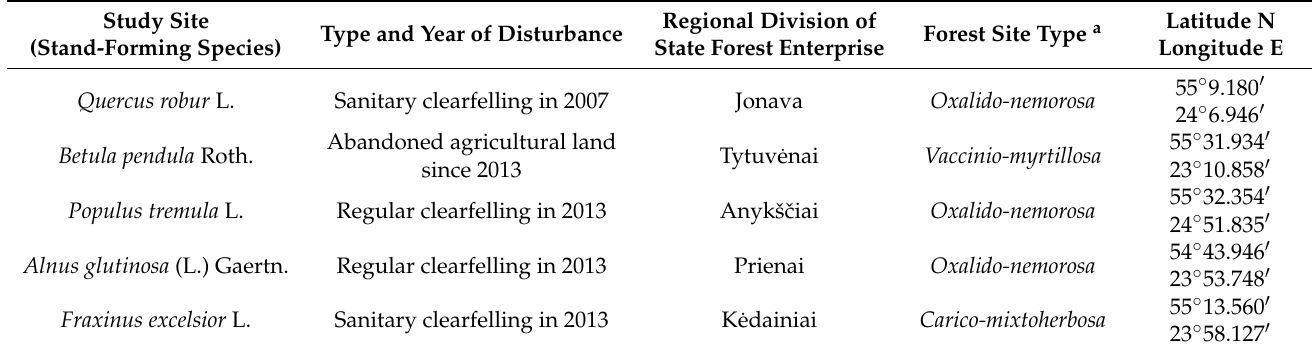
Table 1. Main characteristics of the study